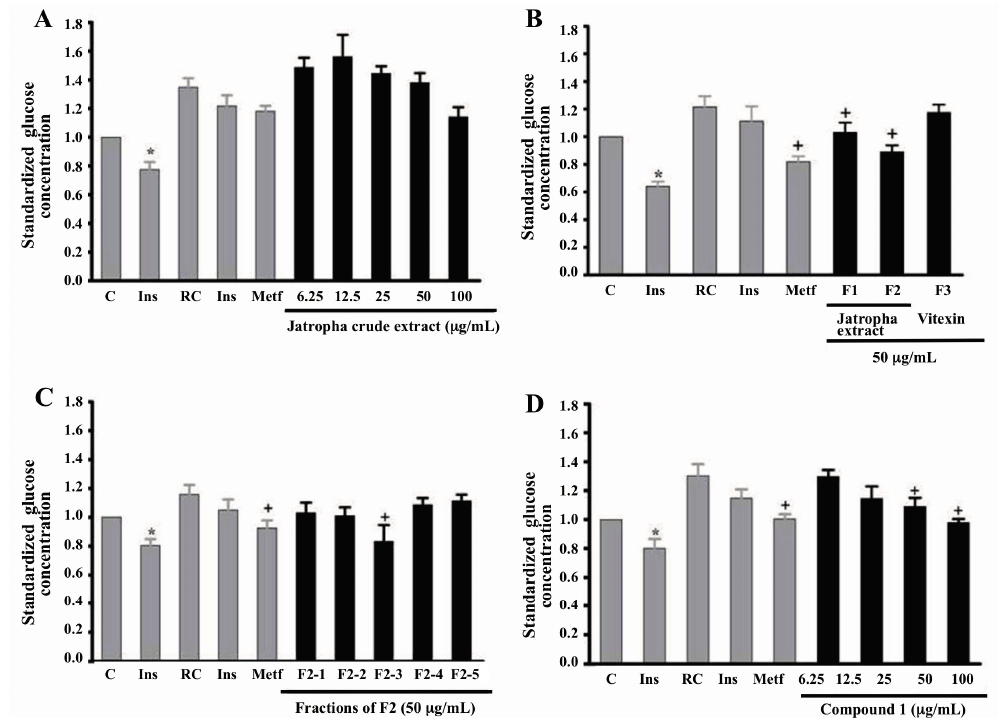
Figure 2. Glucose uptake in C2C12 insulin-resistant myotubes. ( A ) Cells treated with crude Jatropha extract; ( B ) Cells treated with diethyl ether F1, ethyl acetate F2 extracts and vitexin F3; ( C ) Cells treated with chromatographic fractions F2-1 to F2-5; ( D ) Cells treated with compound 1 . C = Non-resistant control; Ins = treated with 100 nM insulin; RC = resistant control; Ins treated with 100 nM insulin; Met = treated with 1 mM metformin. The experiments were completed in triplicate. * Indicates p < 0.05 for Student’s t -test comparison of Control vs. Insulin Control. + Indicates p < 0.05 for ANOVA and Duncan’s multiple-range tests. Error bars represent